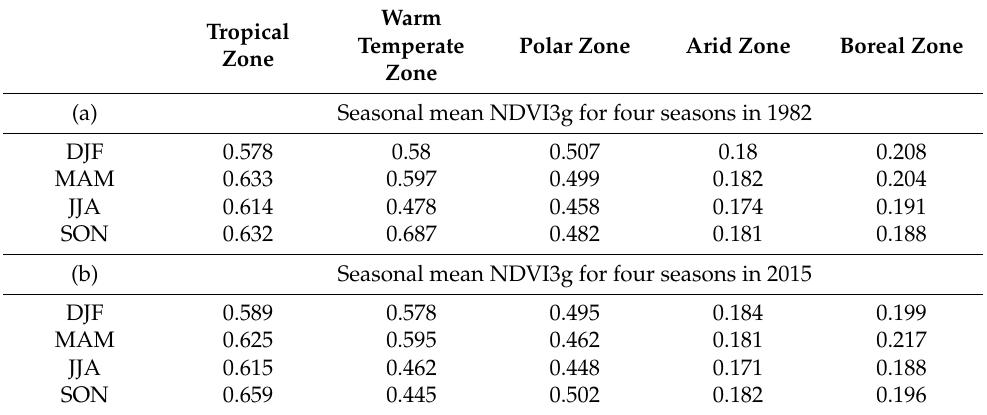
Table 2. Statistical Analysis of the mean NDVI3g value throughout four